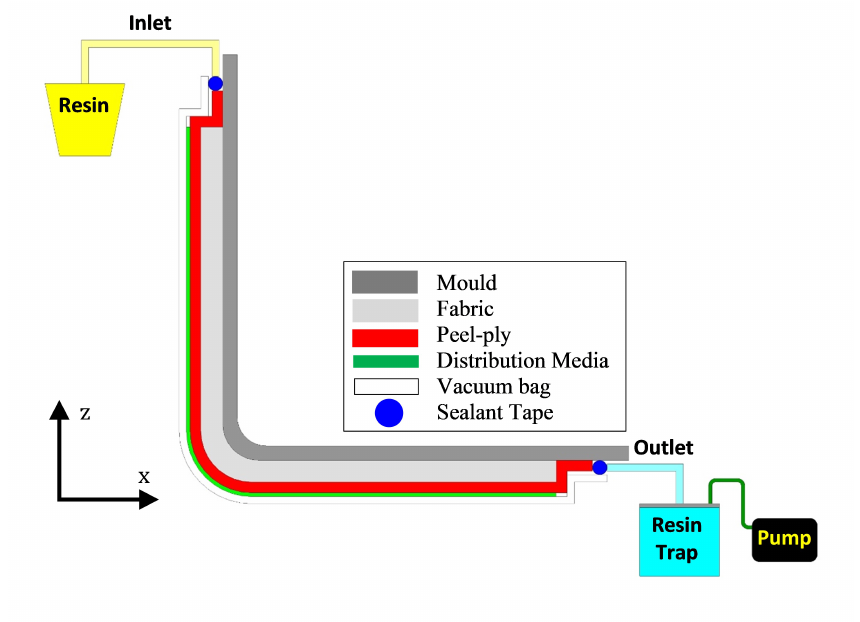
Figure 6. A VARTM experimental setup used for a curved or L-shaped composite components